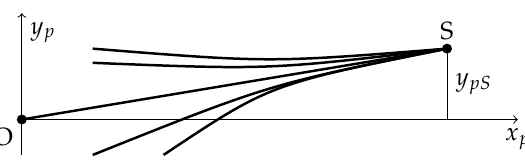
Figure 4. Zeroth-order solution, using proper distances.